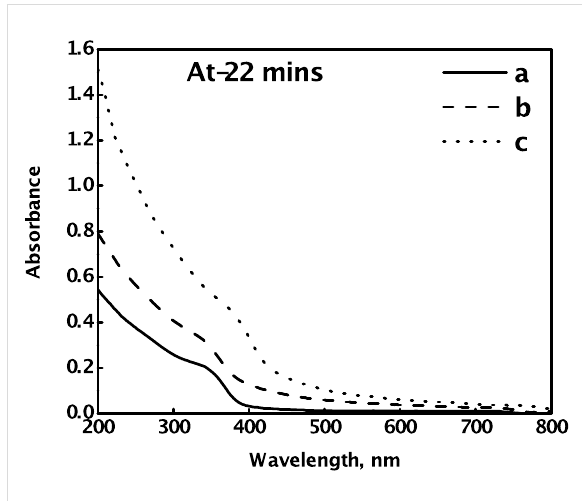
Figure 2: Absorption spectra of PVA-capped CdSe quantum dots, synthesized by the reaction of a fixed Cd(AcO) 2 concentration of 2 × 10 − 3 mol dm − 3 with various concentrations of Na 2 SeSO 3 , (a) 4 × 10 − 3 mol dm − 3 , (b) 8 × 10 − 3 mol dm − 3 , and (c) 1 × 10 − 2 mol dm − 3 , in the presence of 9.2% PVA, at 27 °C.